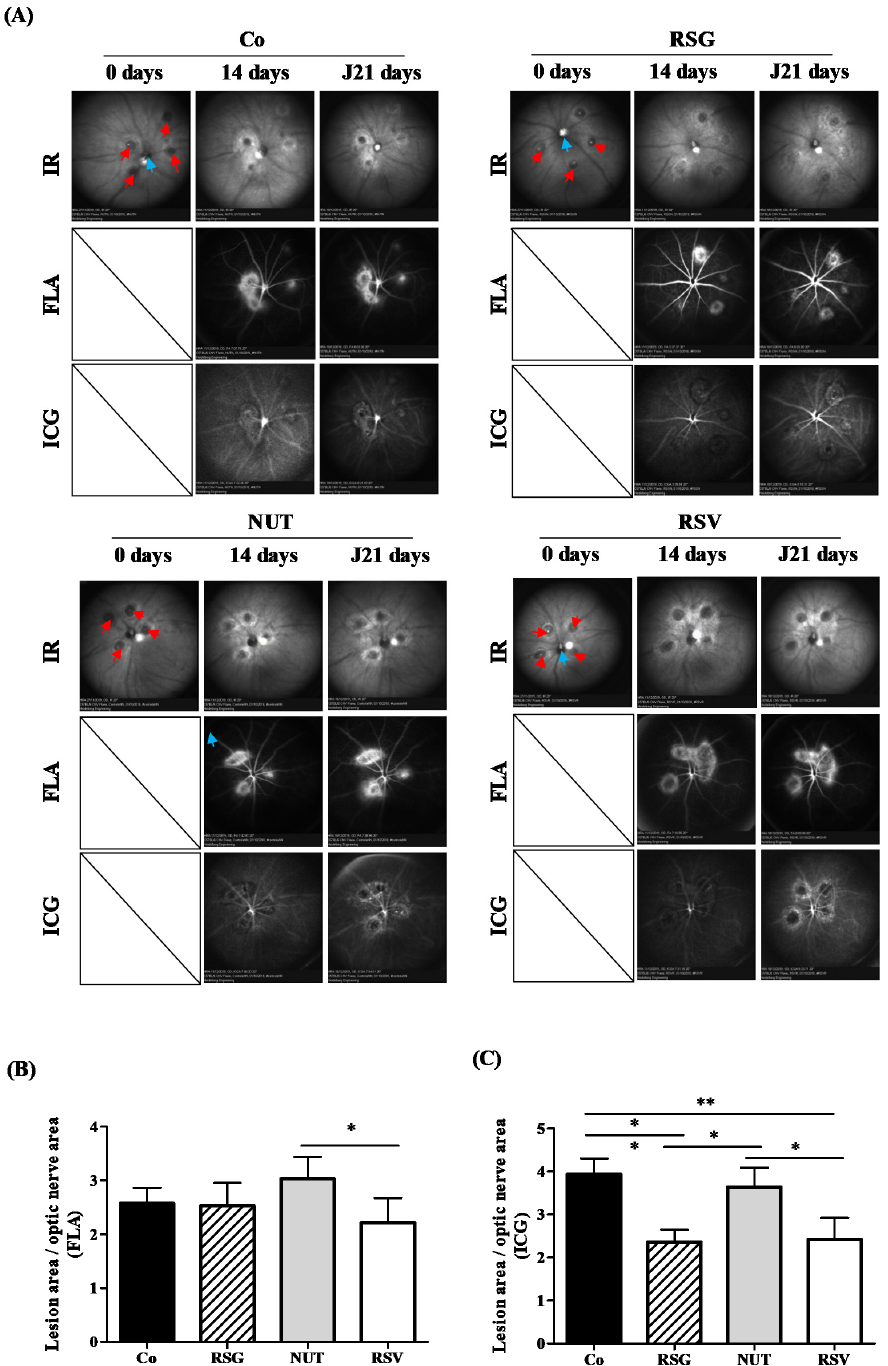
Figure 1. RSG decreases laser-induced CNV in mice. ( A ) Fundus images of mice that were either untreated (Co) or supplemented with RSG (12 µ M), NUT (12 µ M), or RSV (20 µ M) for 14 days prior to CNV induction. Infrared (IR) pictures show the four laser impacts at day 0 (red arrows) as well the optic nerve head positioned at the center of the image (blue arrows). Vascular lesions around laser spots are visible at 14 and 21 days following CNV induction on fluorescein (FLA) and indocyanin green (ICG) angiographies at inner retinal and choroidal levels, respectively. ( B ) Quantitative analysis of vascular lesion areas in the inner retina did not reveal significant differences between animals supplemented with RSG, NUT, and RSV when compared with untreated mice, whereas ( C ) a focused evaluation at the level of choroid showed significantly lower development of CNV in animals supplemented with RSG and RSV. Data are presented as means ± SEM. p values were determined by a one-way ANOVA followed by a Mann–Whitney test. * p < 0.05 and ** p < 0.01.